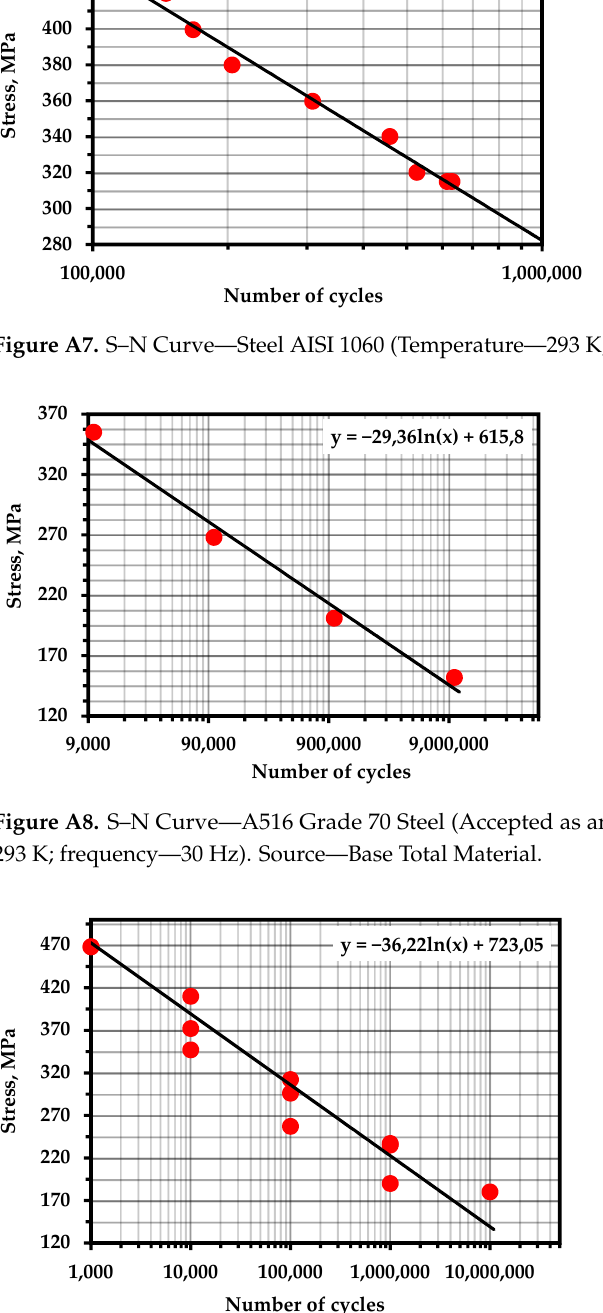
Figure A9. S–N Curve—Steel AISI 304LN (Temperature—293 K; frequency—30 Hz). Source—Base Total Material.